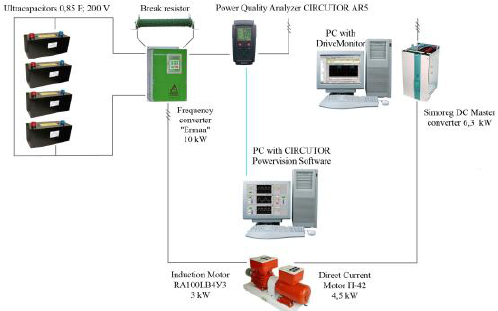
Figure 6. Functional diagram of experimental setup